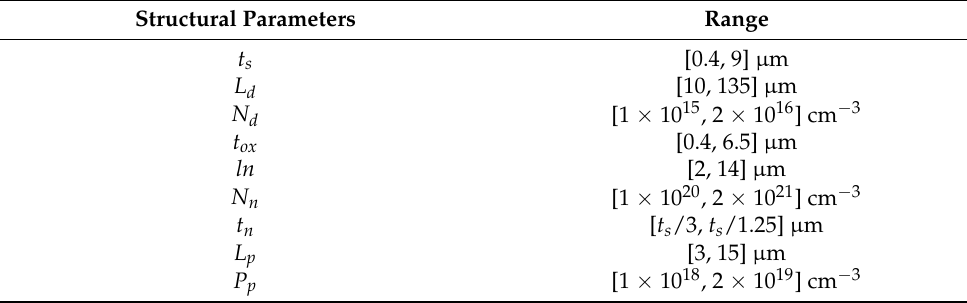
Table 1. Structural parameters in the drift region. Structural